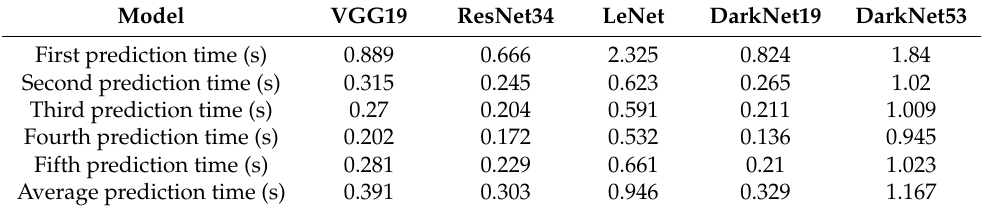
Table 2. Prediction time of the implementation of the 5 models.